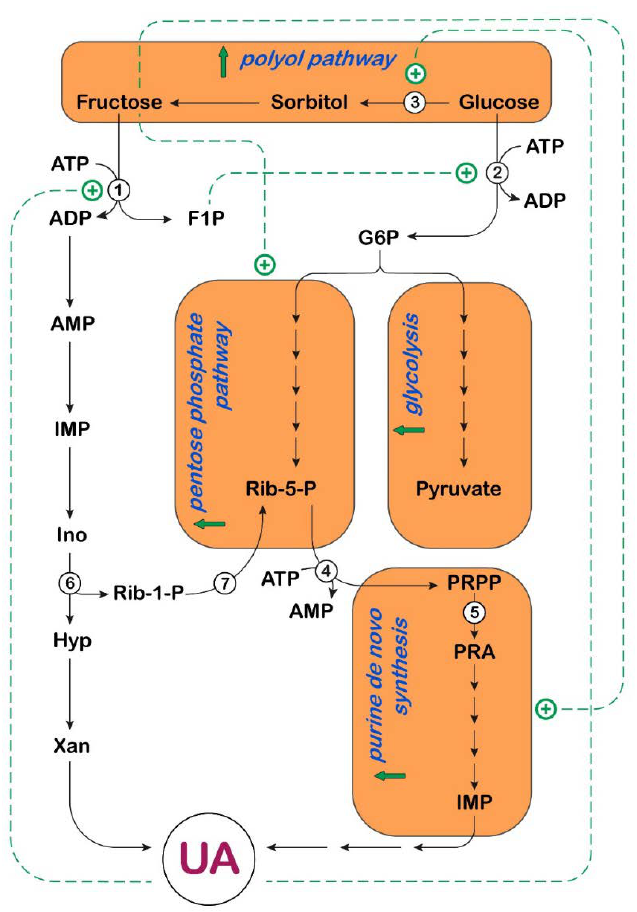
Figure 3. Effect of UA on carbohydrate and purine metabolism in liver. UA activates fructokinase (enzyme 1), increasing the formation of fructose-1-phosphate (F1P), which activates glucokinase (enzyme 2), by disrupting its interaction with glucokinase regulatory protein, contributing to the increase in the glycolytic flux. UA also activates aldose reductase (enzyme 3), enabling endogenous fructose formation through the polyol pathway. Fructose, through up-regulation of transketolase, favors the non-oxidative branch of the pentose phosphate pathway, for the synthesis of ribose-5- phosphate (Rib-5-P), essential for the formation of 5-phosphoribosyl-1-pyrophosphate (PRPP), a precursor of IMP, through the purine de novo synthesis pathway. The purine de novo pathway is also accelerated by depletion of adenine nucleotides, caused by a load of fructose (see Figure 2),